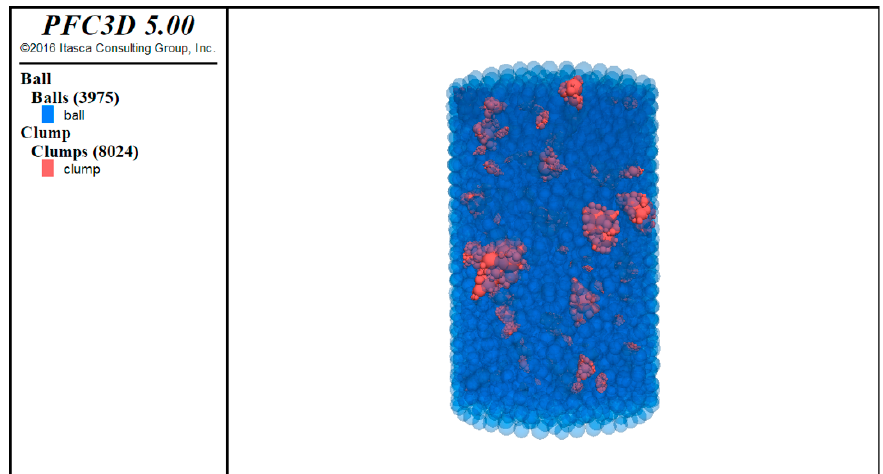
Figure 10. Asphalt mixture discrete element specimen.